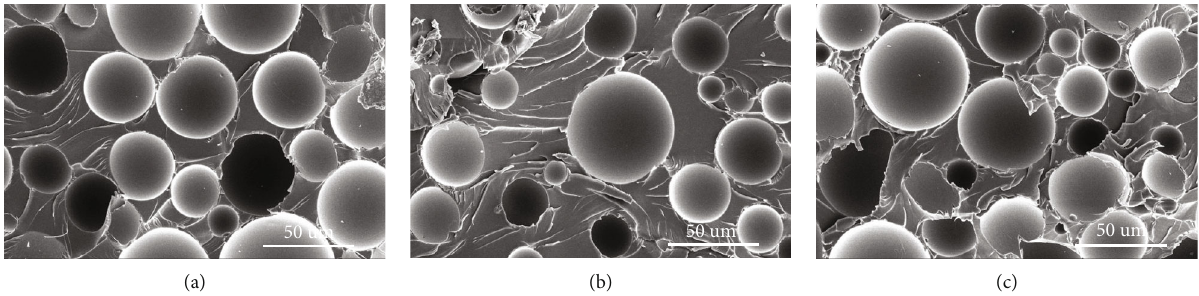
Figure 6: Compatibility of HGMs with the EP matrix with volume fractions of (a) 20%, (b) 40%, and (c)